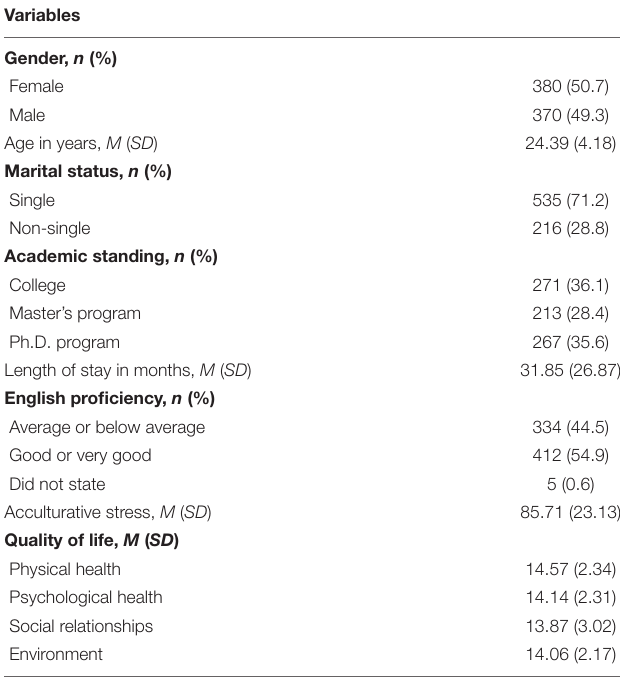
TABLE 1 | Descriptive statistics of key study variables ( N = 751).